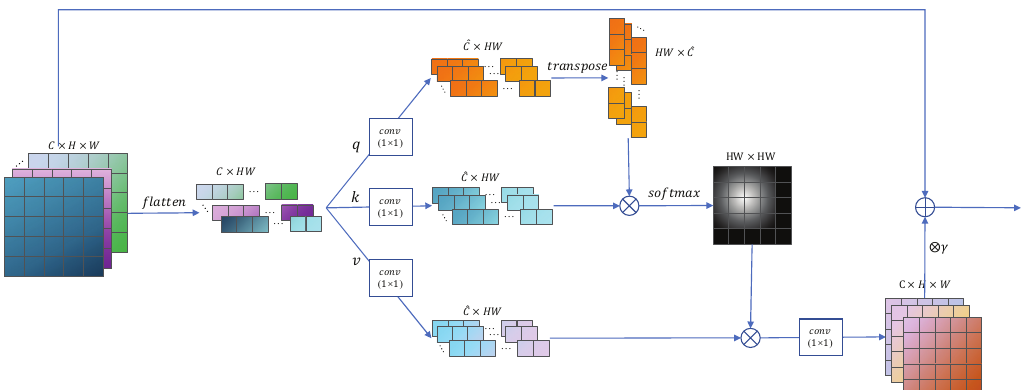
Figure 3. Self-attention module. The tensor shapes of the intermediate variable are annotated next to them. “ ⊕ ” represents the element-wise sum, and ” ⊗ ” represents matrix